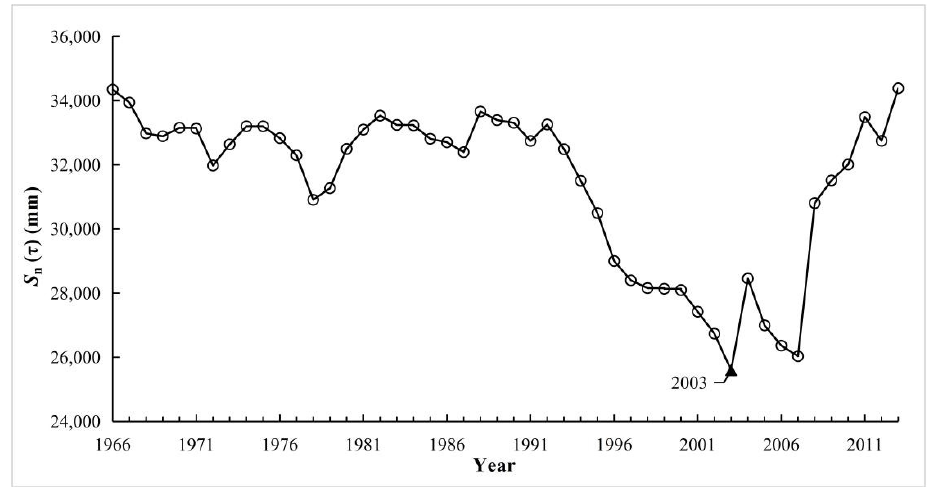
Figure 3. S n ( τ ) change curve of annual runoff depth by ordered clustering (OC) analysis method from 1966 to 2013 in the YRHA.